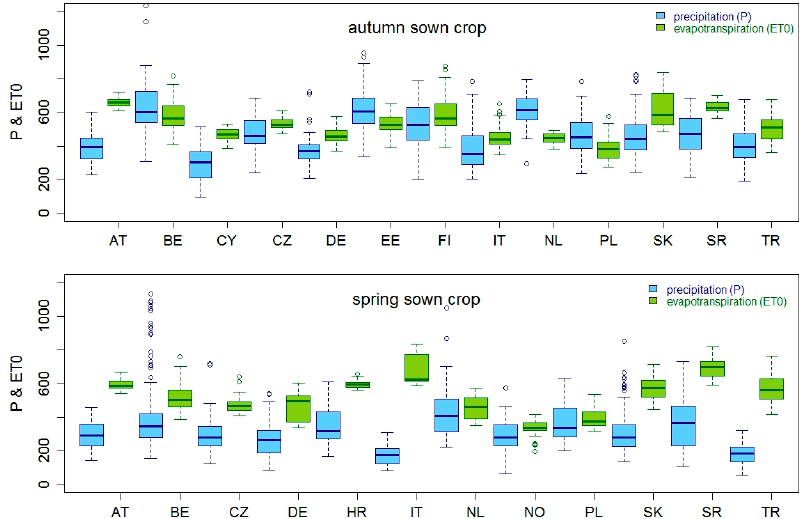
Figure 4. Precipitation ( P in mm) and reference evapotranspiration ( ET0 in mm) during the growing season of autumn and spring sown crops across the European regions for the period 1992–2012. A two letter code refers to the country that the region belongs to.